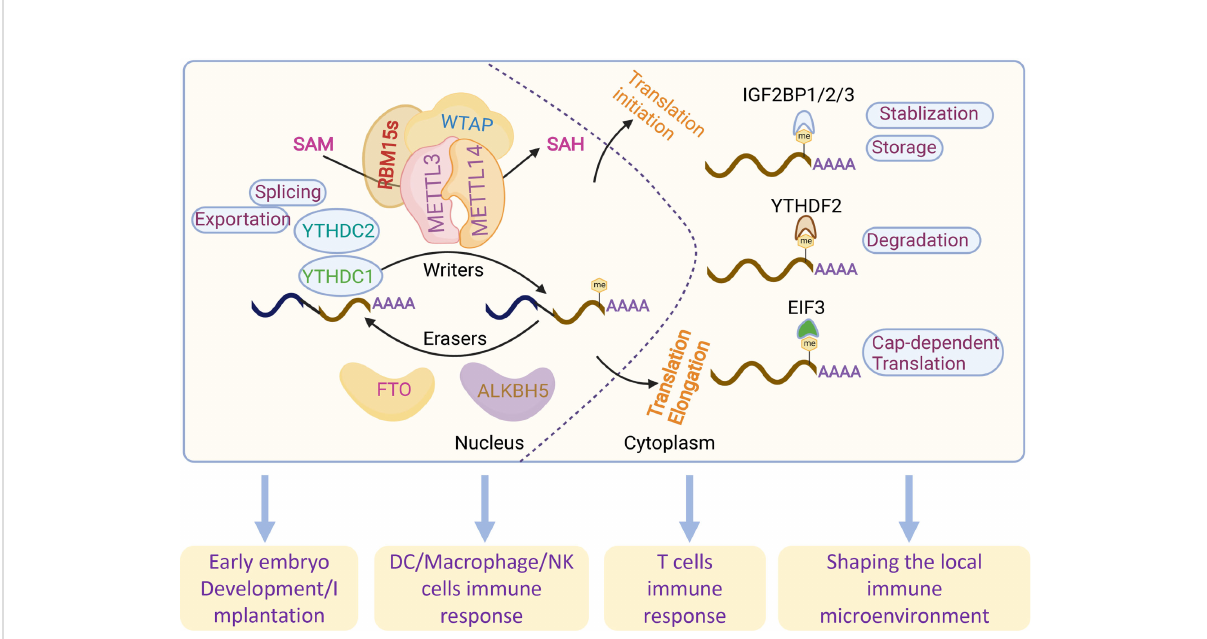
FIGURE 1 Overview of the reversible m6A RNA modi fi cations and related functions. m6A modi fi cations are regulated by m6A writers (METTL3, METTL14, RBM15s and WATP) and readers (FTO and ALKBH5). m6A methylation is recognized by different readers (YTHDC1-2, YTHDF1-3 and EIF3) by regulating RNA splicing, exportation, translation, degradation, stabilization and